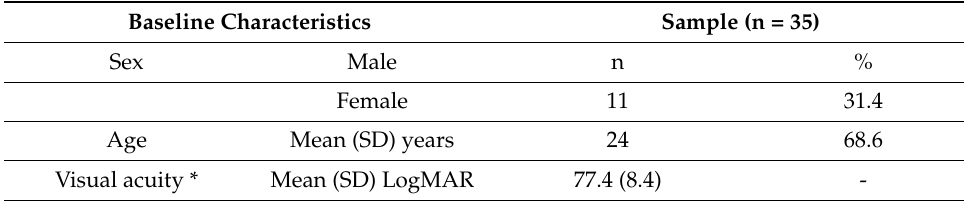
Table 1. Demographic characteristics of